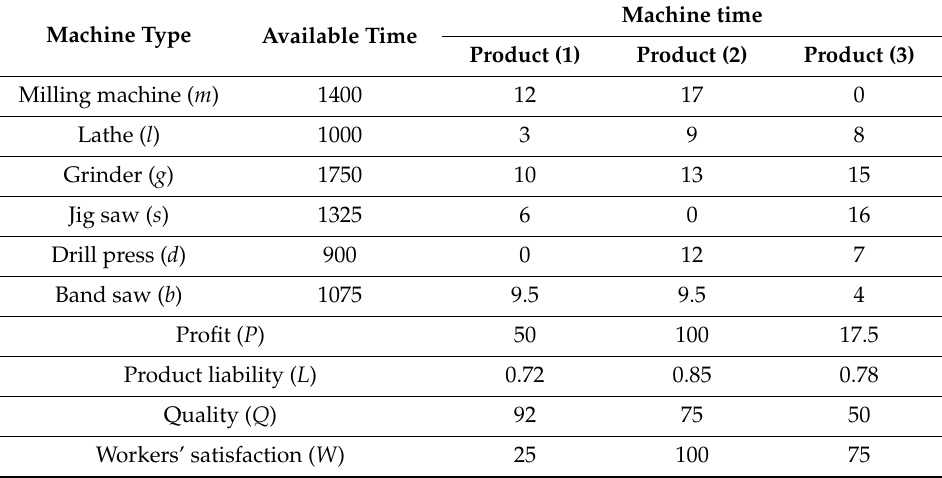
Table 1. Portfolio of available capacities with deterministic